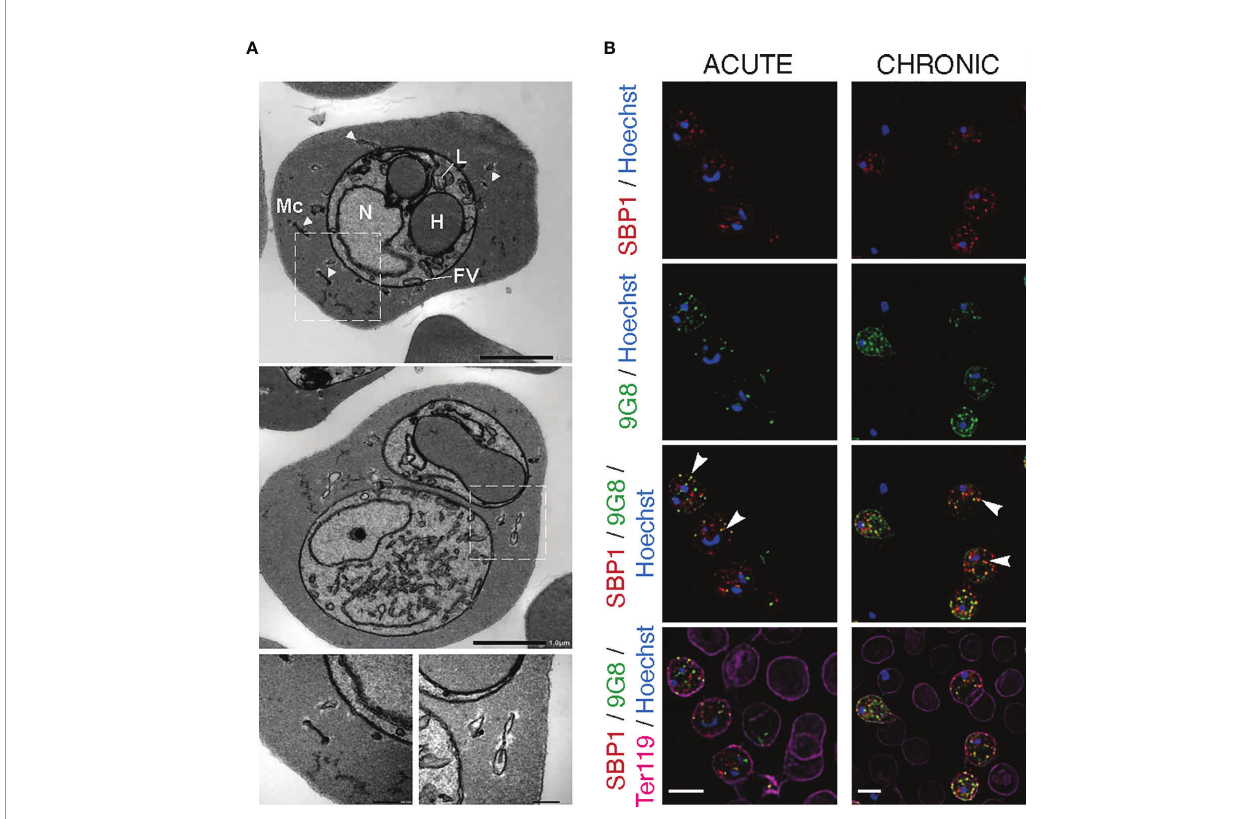
FIGURE 4 | Maurer ’ s clefts-like structures in P. c. chabaudi AS infected erythrocytes. (A) Transmission electron micrographs of a P. chabaudi MT acute phase trophozoite, inside a mouse erythrocyte. The white arrowheads indicate Maurer ’ s clefts within the iRBC cytosol. Insets show sections of the areas highlighted. Scale bar length corresponds to 1 m m and 0.2 m m in insets. FV, Food Vacuole; H, Haemoglobin Filled Compartment; L, Lipid Droplets; Mc, Maurer ’ s clefts; N, Nucleus. (B) Immuno fl uorescence assays of MT acute- (left panels) and chronic- (right panels) phase WT P. chabaudi parasites at the late trophozoite-stage. Blood was isolated from C57Bl/6 RAG1 -/- mice. Parasites were primarily stained with the anti-PbSBP1 antibody (De Niz et al., 2016) (red) and then with the anti-clone 6 (9G8) monoclonal antibody (green). The RBC surface membrane was stained with the anti-Ter119 monoclonal antibody (magenta), and parasite nuclei were stained with Hoechst (blue). The white arrowheads indicate co-localisation of SBP1 with 9G8. Images were taken from confocal sections of acetone:methanol fi xed parasites at X630 magni fi cation. Scale bar length corresponds to 5 m